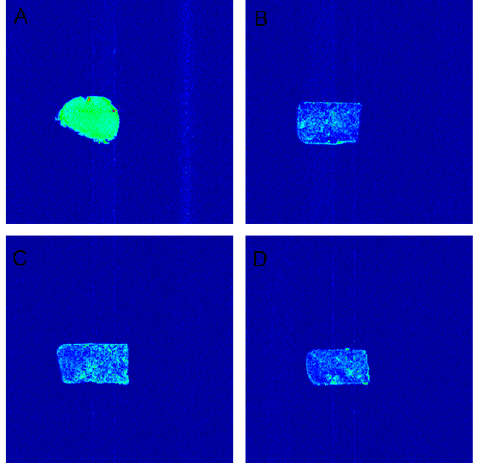
Figure 3. Pseudo color map of different tofu types. ( A ) Commercially available lactone tofu. ( B ) Lactone tofu with 5% cellulose. ( C ) Lactone tofu with 10% cellulose. ( D ) Lactone tofu with 15% cellulose.